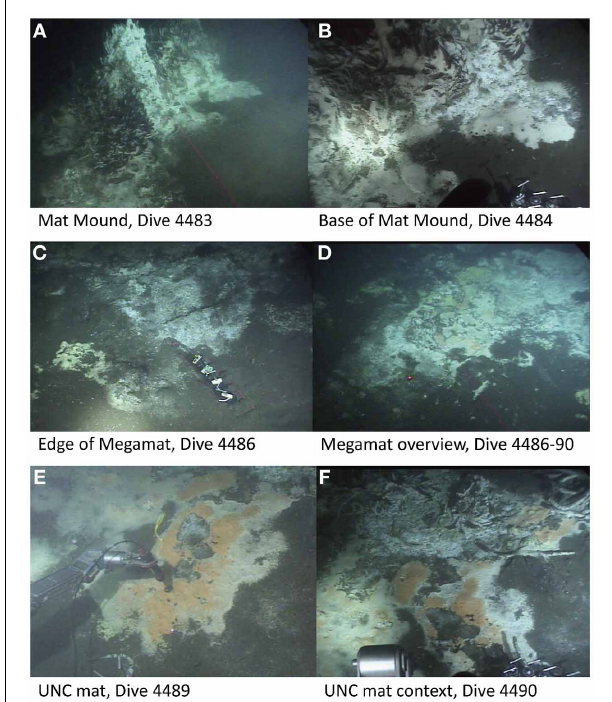
FIGURE 2 | Selected sampling sites of the Southern Guaymas trench. This area is characterized by the occurrence of Riftia around hydrothermal mounds such as Mat Mound (A,B) and dense bacterial mats of white, orange or yellow color that are mainly formed by the giant sulfide oxidizer Beggiatoa on the sediment surface, for example at Megamat (C,D) and the UNC mat (E,F) . Image source: Woods Hole Oceanographic Institution, Woods Hole,